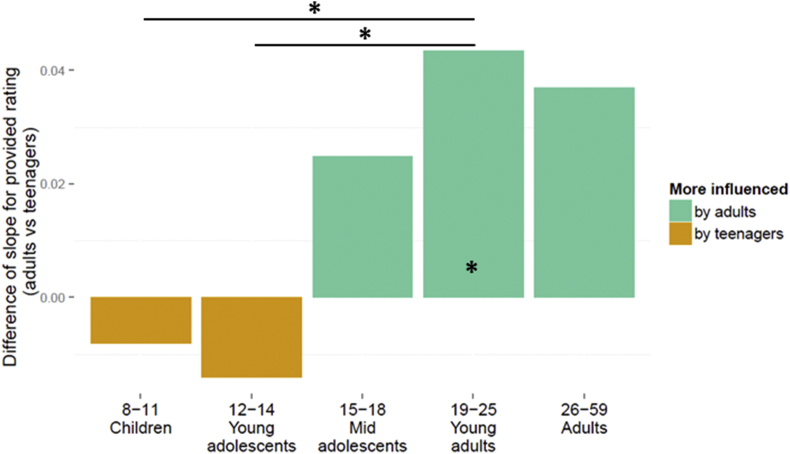
The graph presents the difference between the two slopes for the average change in risk rating after seeing the ratings of the social-influence groups, predicted by using the estimates of the linear mixed-effect model, for five age groups. A positive difference indicates a greater degree of influence by the social-influence group adults than by teenagers. A negative difference indicates a greater degree of influence by the social-influence teenagers than by adults. Asterisks indicate significant main effect of peer-influence (adults vs teenagers) within age group and interaction on peer-influence effects between age groups (* p < 0.05).